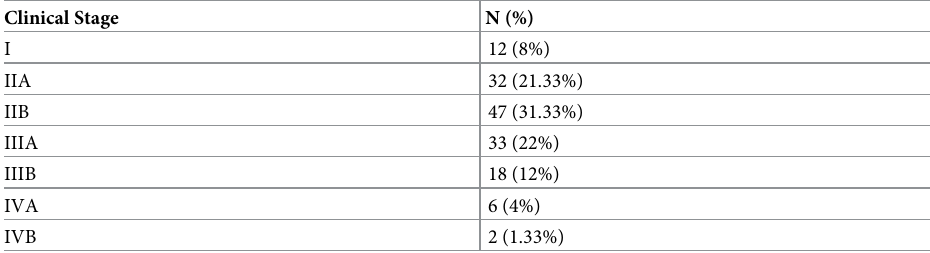
Table 5. Clinical stages of cervical carcinoma cases at